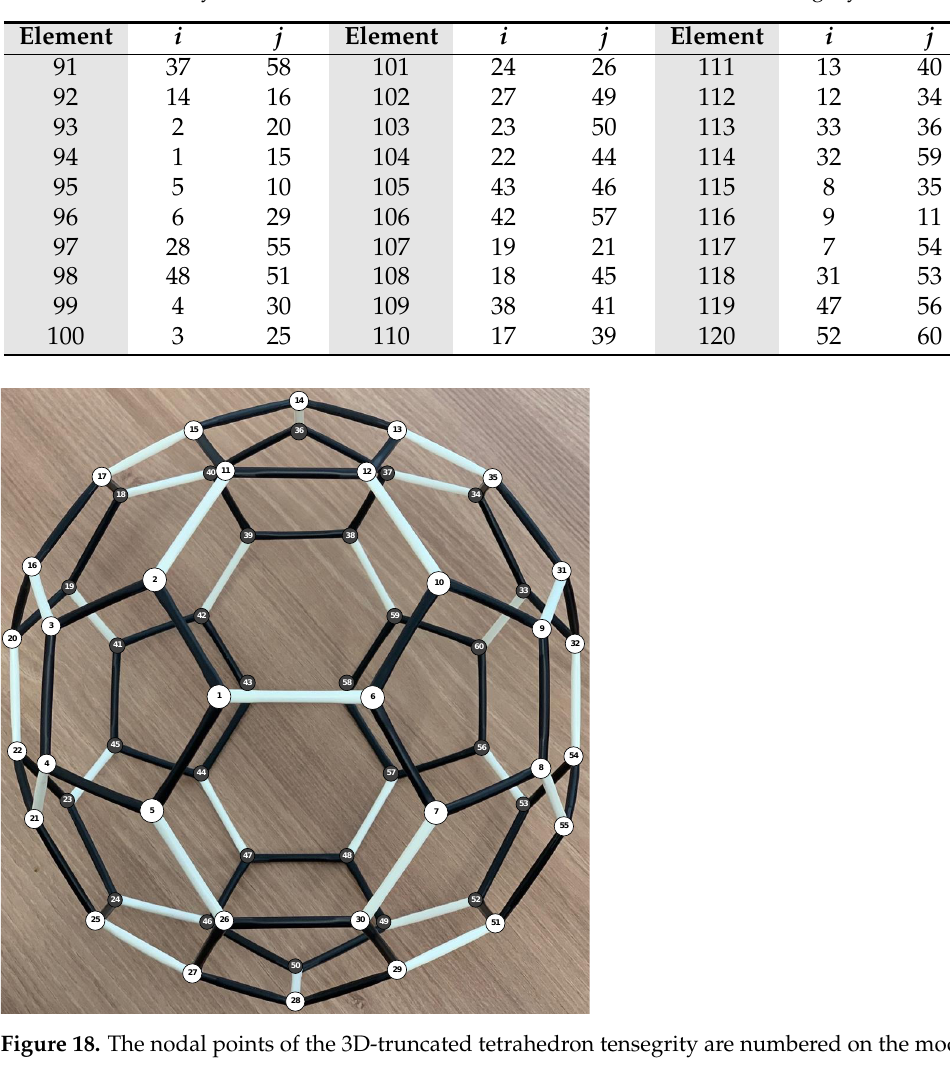
Table 6. Connectivity of the strut members for the 3D-truncated tetrahedron tensegrity.